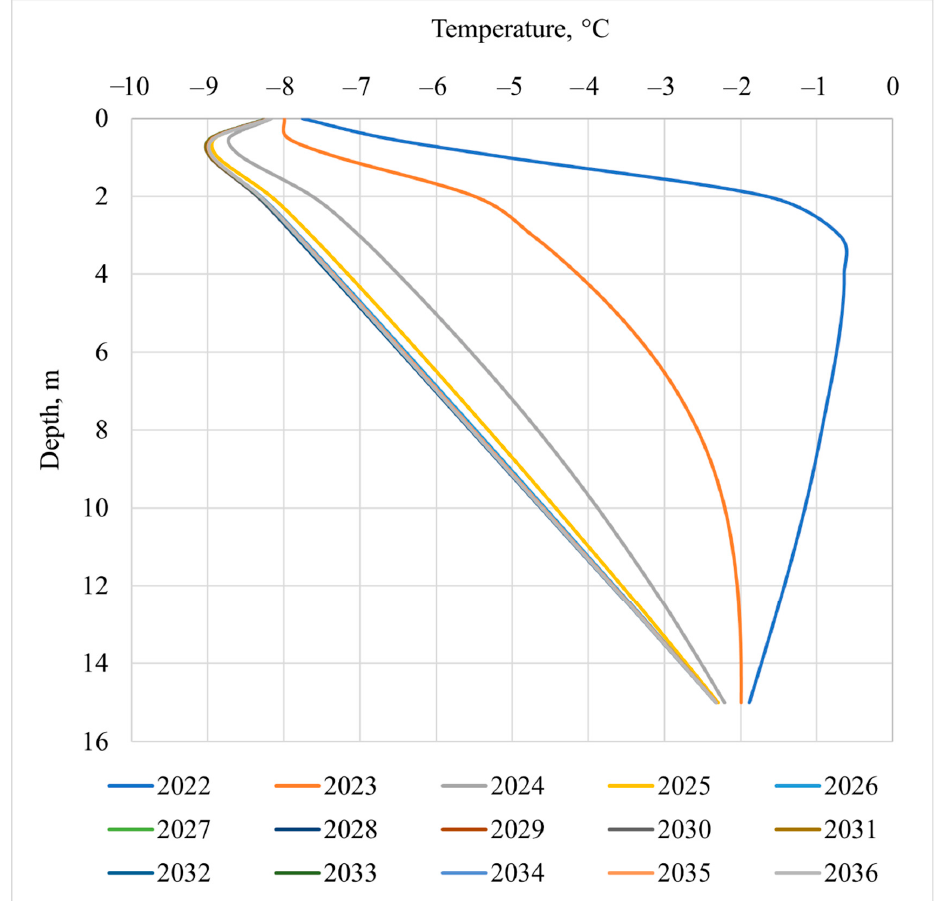
Figure 7. Dynamics of mean annual ground temperatures from 2022 to 2036 for variant 1 and scenario II.